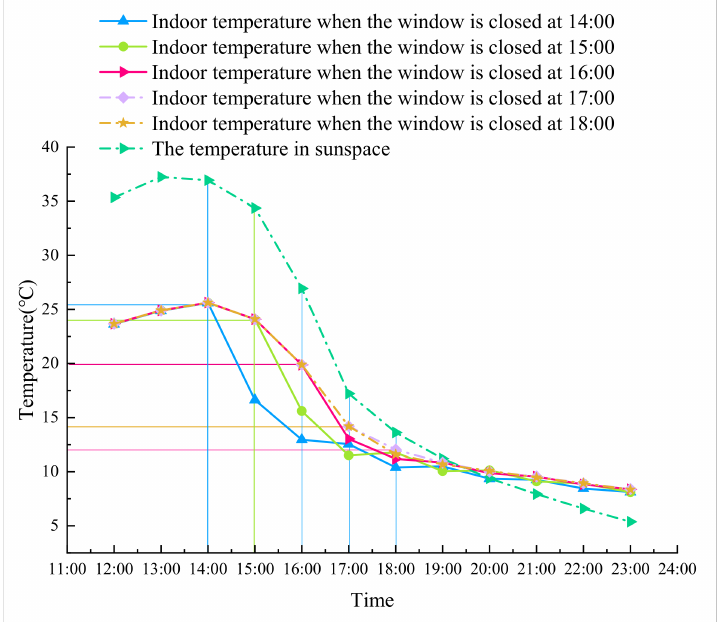
Figure 8. Temperature comparison chart for different window closing